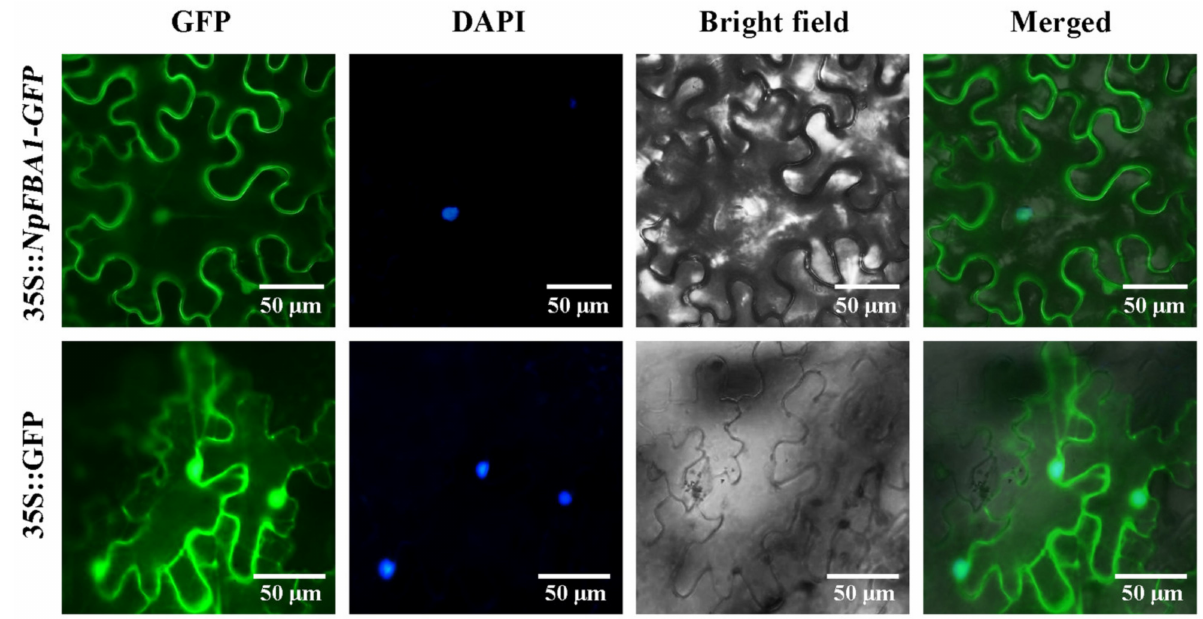
Figure 2. The subcellular localization of NpFBA1 in N. benthamiana epidermal cells. GFP: Green fluorescent protein. DAPI: Nucleic marker. Merged: Merged image of the bright field, GFP, and DAPI results. The above image is a random field of view taken from a fluorescent region of the tobacco